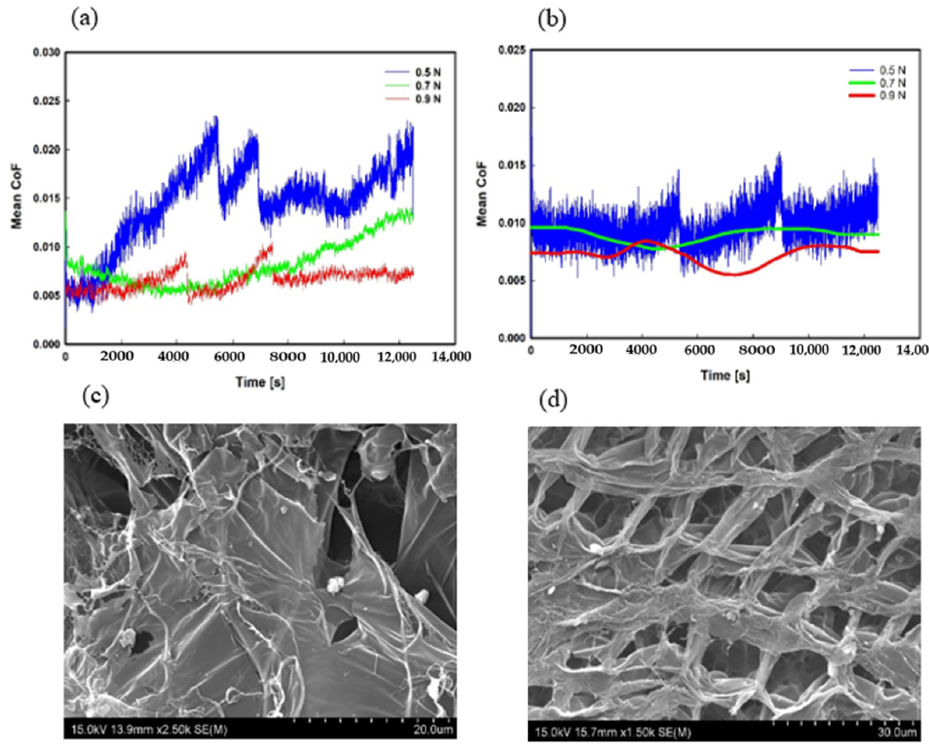
Figure 6. Variations of CoF versus time for 1000 m sliding wear tests at 0.5 N, 0.7 N, and 0.9 N; in ( a ) NRHs and ( b ) NCHs. SEM images of the superficial layer in ( c ) NRHs and ( d ) NCHs.